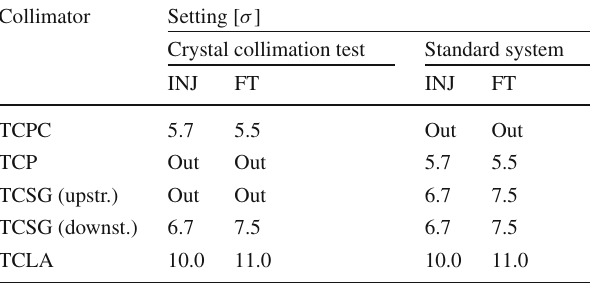
√ β(cid:5) , computed for a normalized Table 2 Setting in units of beam σ = emittance (cid:5) ∗ = 3 . 5 µ m, at the injection (450Z GeV, “INJ”) and flat- top (6.5Z Tev, “FT”) energies for the relevant IR7 devices used in the channeling experiment: crystals (TCPC), primary collimators